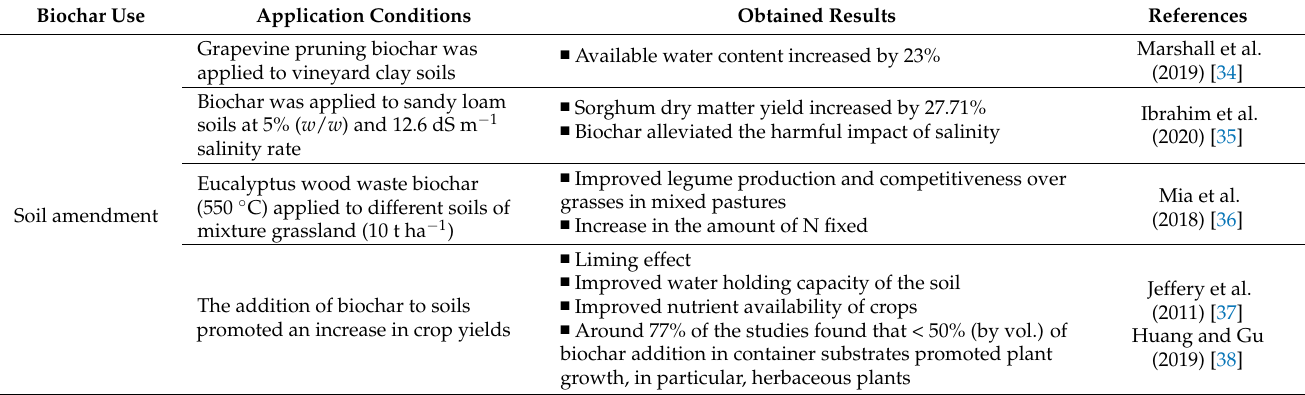
Table 3. Summary of studies about biochar applications in agriculture and livestock